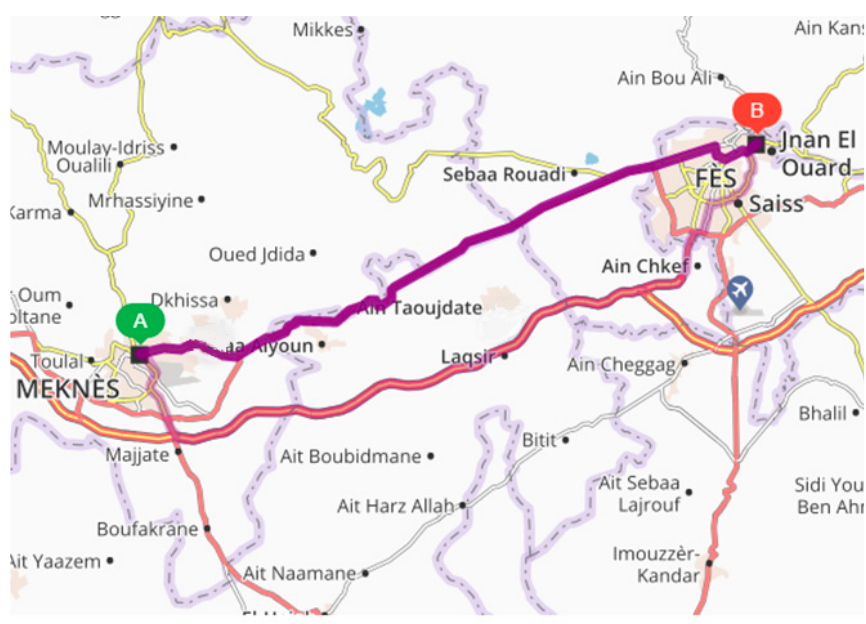
Figure 12. The Morocco highway (Meknes “A”–Fez “B”).